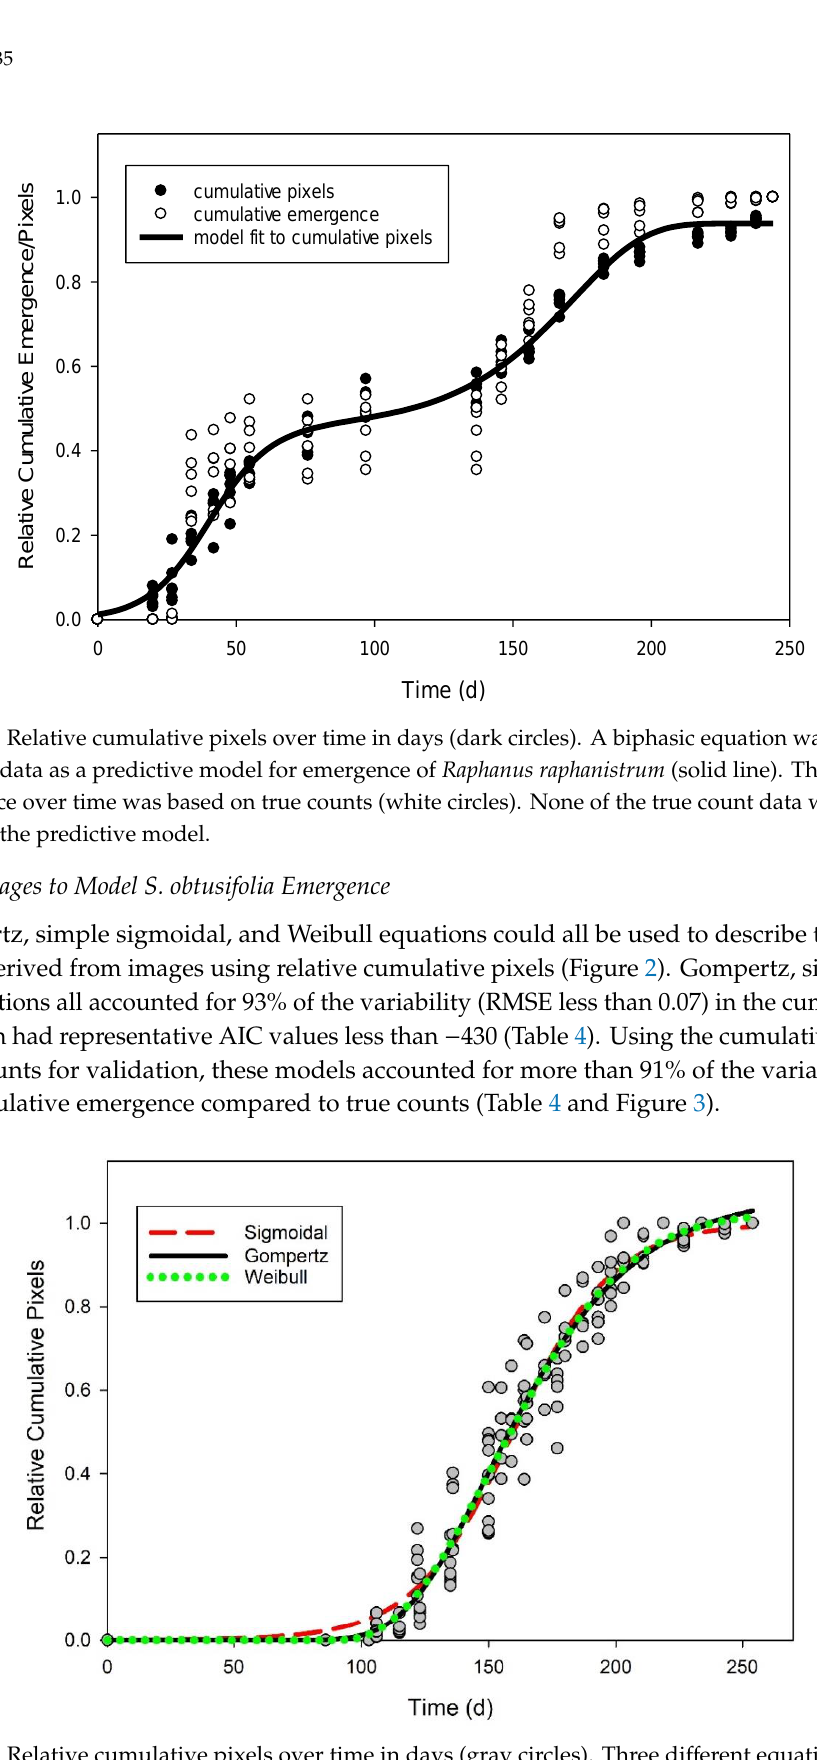
Figure 3. Expected Senna obtusifolia over time as predicted by the Gompertz model fit to relative cumulative pixels (solid line). Observed relative cumulative emergence from true counts of Senna obtusifolia over time (green circles).